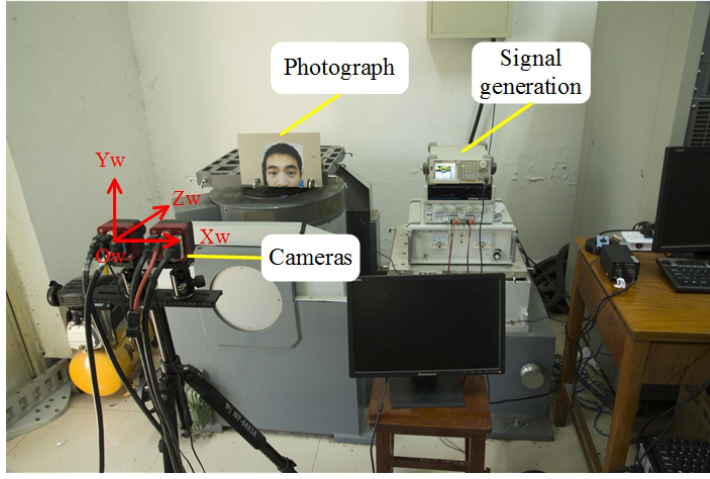
Figure 3. Experimental setup for the dynamic calibration.